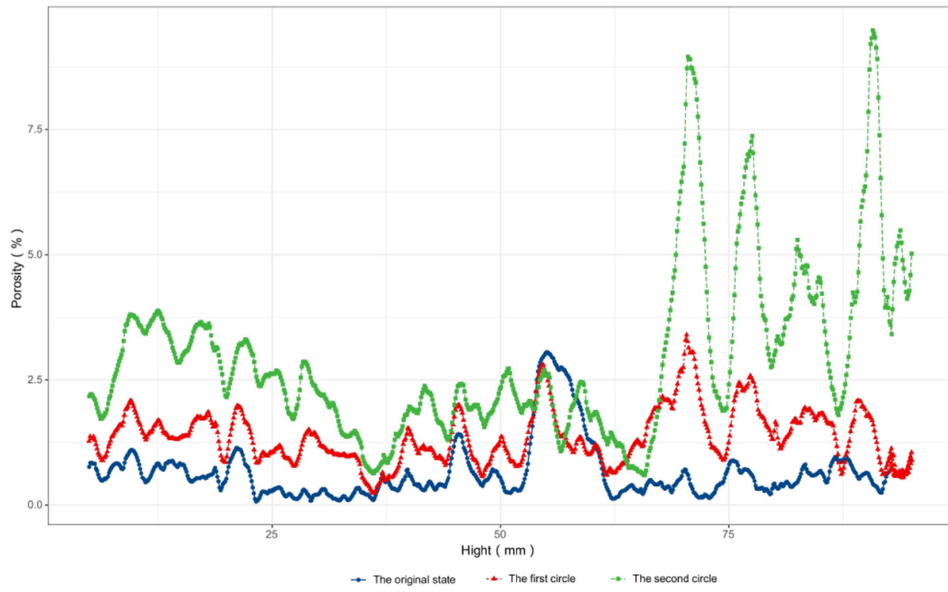
Figure 13. Concrete sample porosity vertical height distribution.